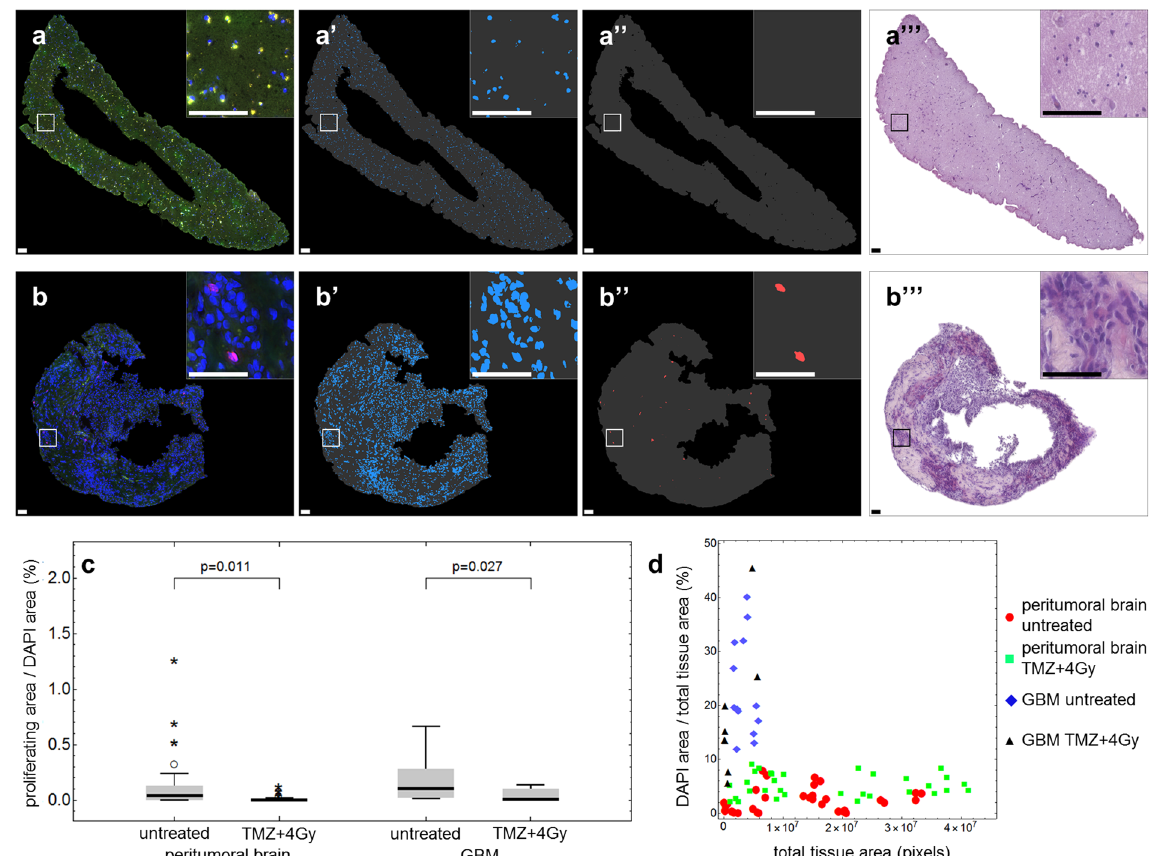
Figure 6. Histological finding of reduced proliferation after treatment supports mRNA expression data. Paraffin-embedded treated and untreated peritumoral brain ( a ) and GBM tissue ( b ) was stained with a Ki67 antibody as proliferation marker (red) and DAPI as nuclei marker (blue) and recorded by a slide scanner. Representative images of untreated samples are presented. (Note: green signals are attributed to autofluorescence of the tissue). For quantification, the total tissue area (a’/”, b’/”, gray), the nuclei area (a’, b’) and the Ki67-positive nuclei area (a”, b”) were determined. H/E stainings of consecutive tissue sections are shown in a”’ and b”’. ( c ) Ratio of proliferating area (Ki67- and DAPI-positive pixel area) per DAPI area in untreated and treated (TMZ + 4 Gy) peritumoral brain (left) and GBM tissue (right). ( d ) Ratio of DAPI area per total tissue area compared to total tissue area in pixels in untreated and treated (TMZ + 4 Gy) peritumoral brain (red circles, green squares) and GBM tissue (blue diamonds, black triangles). Biological replicates: 1; Technical replicates: 3; Scanned sections: 33 (untreated peritumoral brain), 32 (treated peritumoral brain), 13 (untreated GBM), 8 (treated GBM). Scale bars: 100 µ m (a), 50 µ m ( b